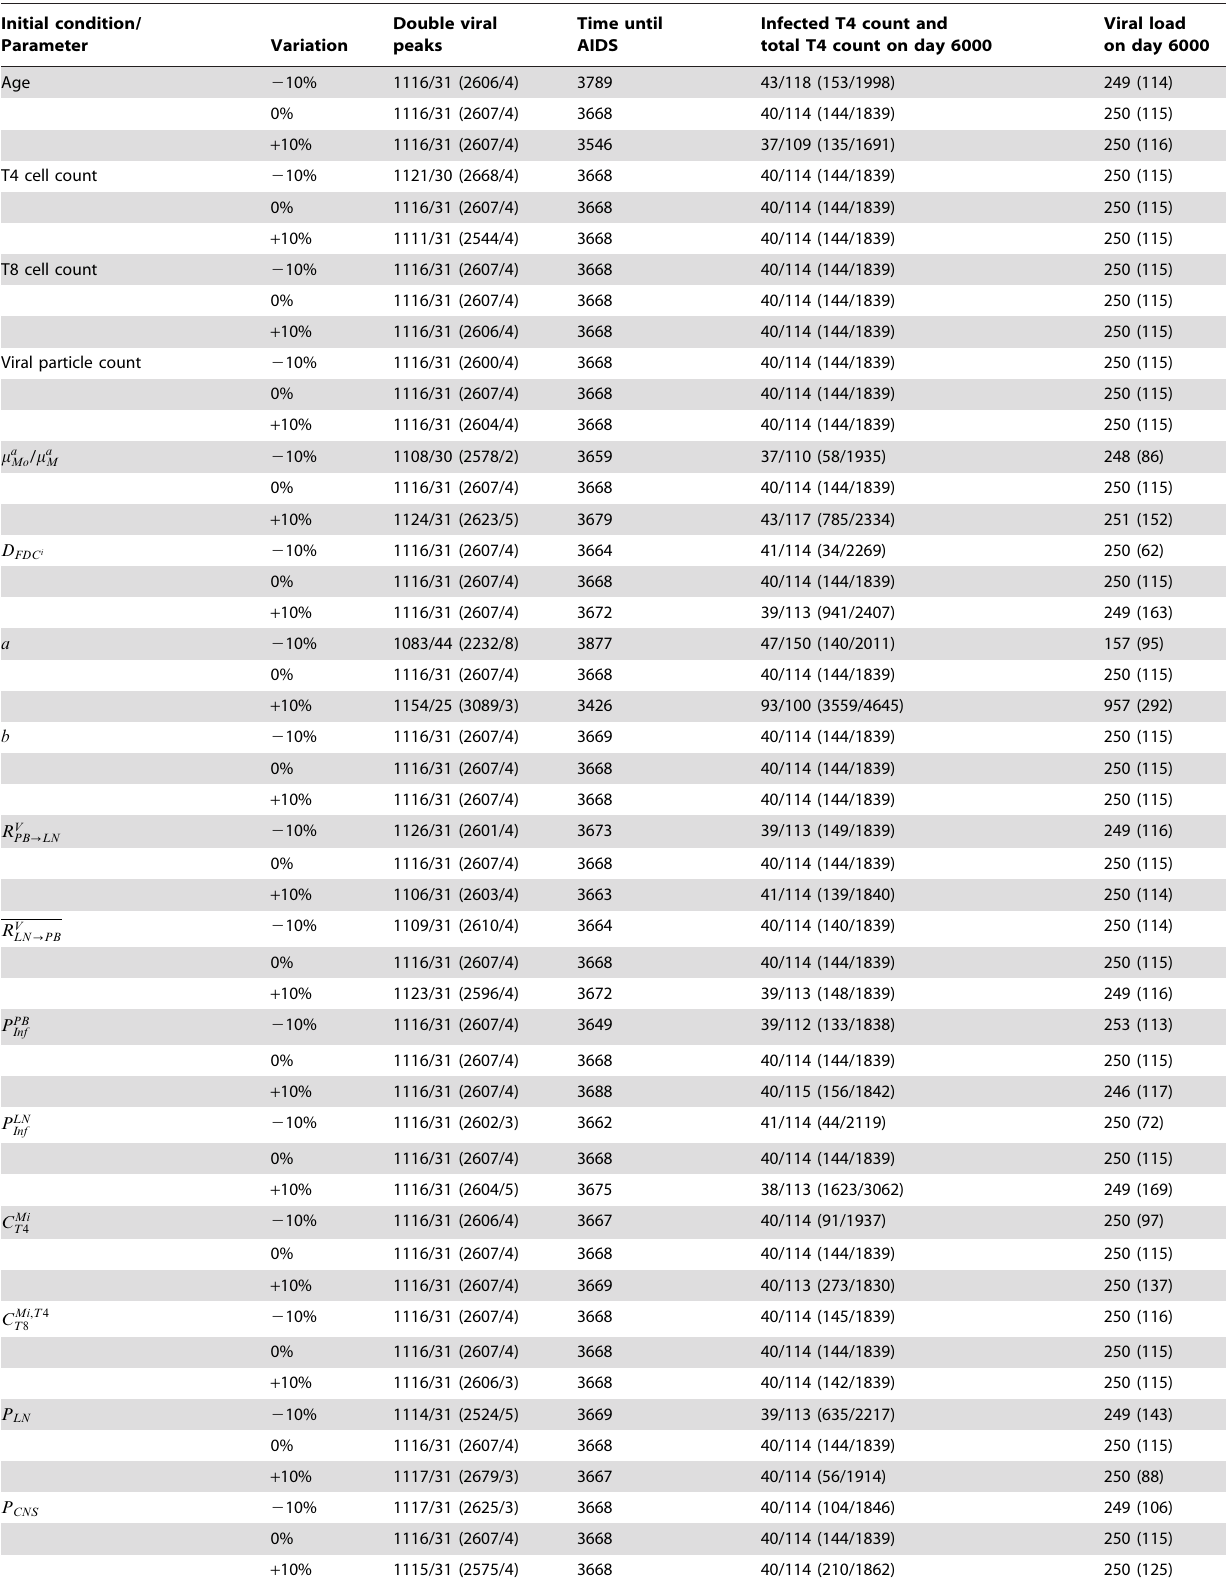
Table 1. Simulation of 6 10% single initial condition/parameter